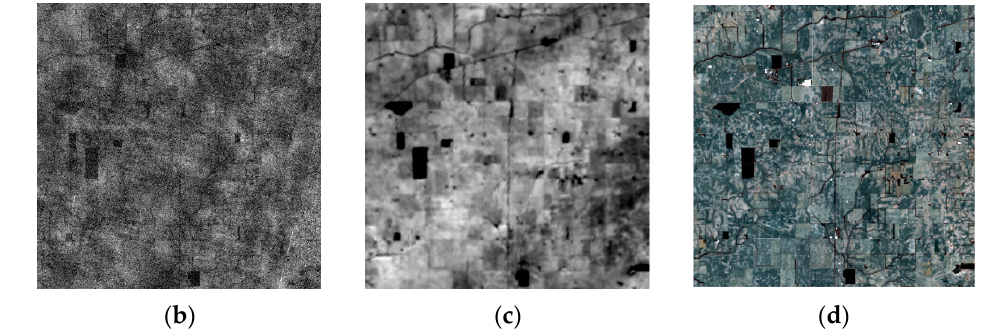
Figure 6. The blue ( a ), cirrus ( b ), thermal ( c ) bands, and RGB composite ( d ) of a Landsat 8 image in Indiana.